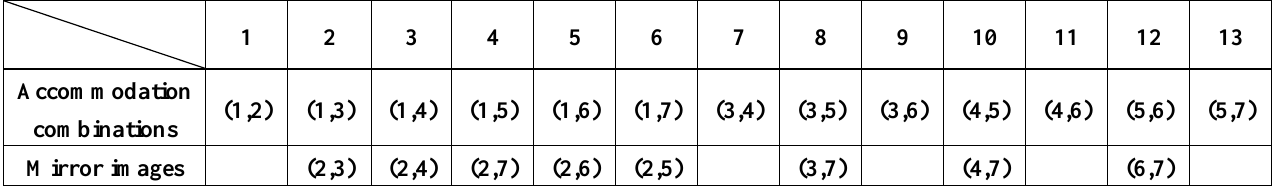
Table 2. Combinations of accommodation rules for Configuration 4 related to Figure